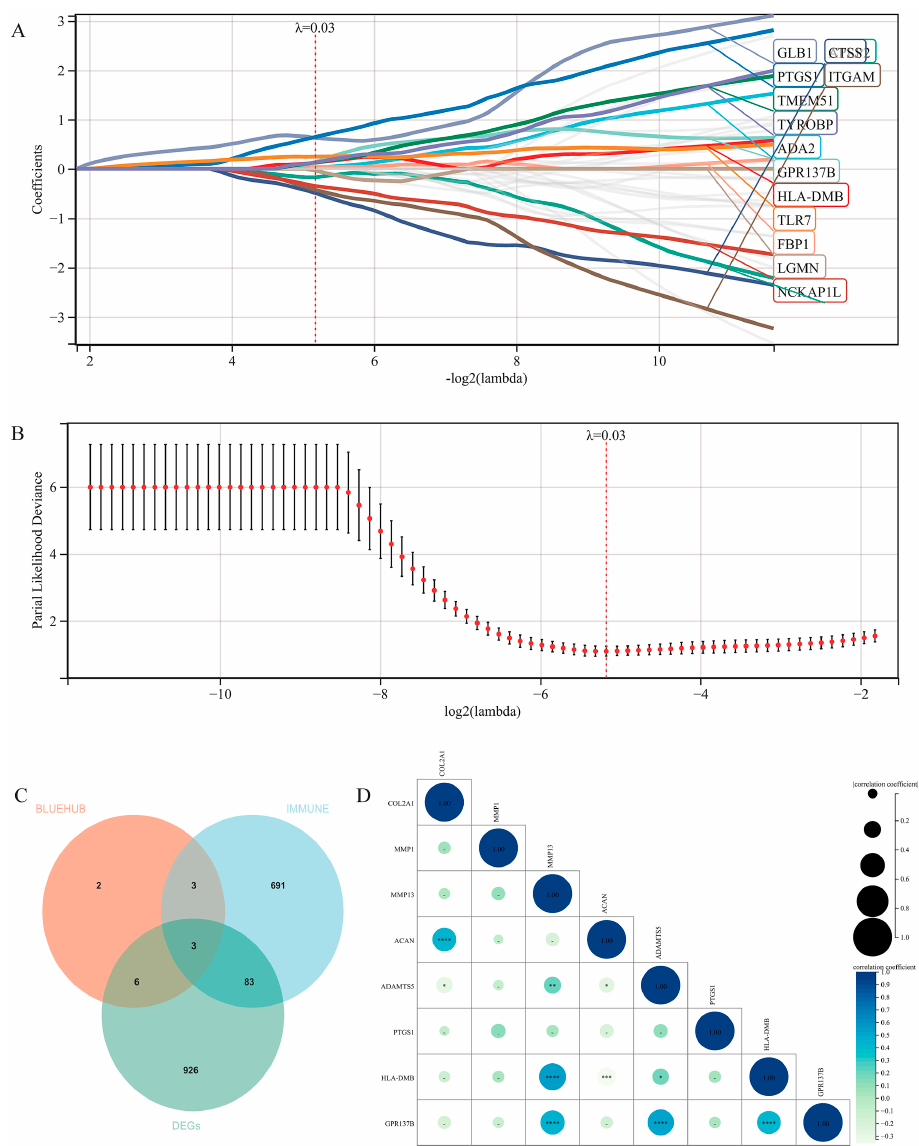
Figure 6. LASSO-cox regression analysis. Coefficient distribution diagram ( A ) Lambda selection ( B ) The intersection of DEGs, immune-related genes and characteristic genes ( C ) Correlation analysis of target genes and OA phenotype-related genes ( D ). * p < 0.05, ** p < 0.01, *** p < 0.001, **** p < 0.0001.